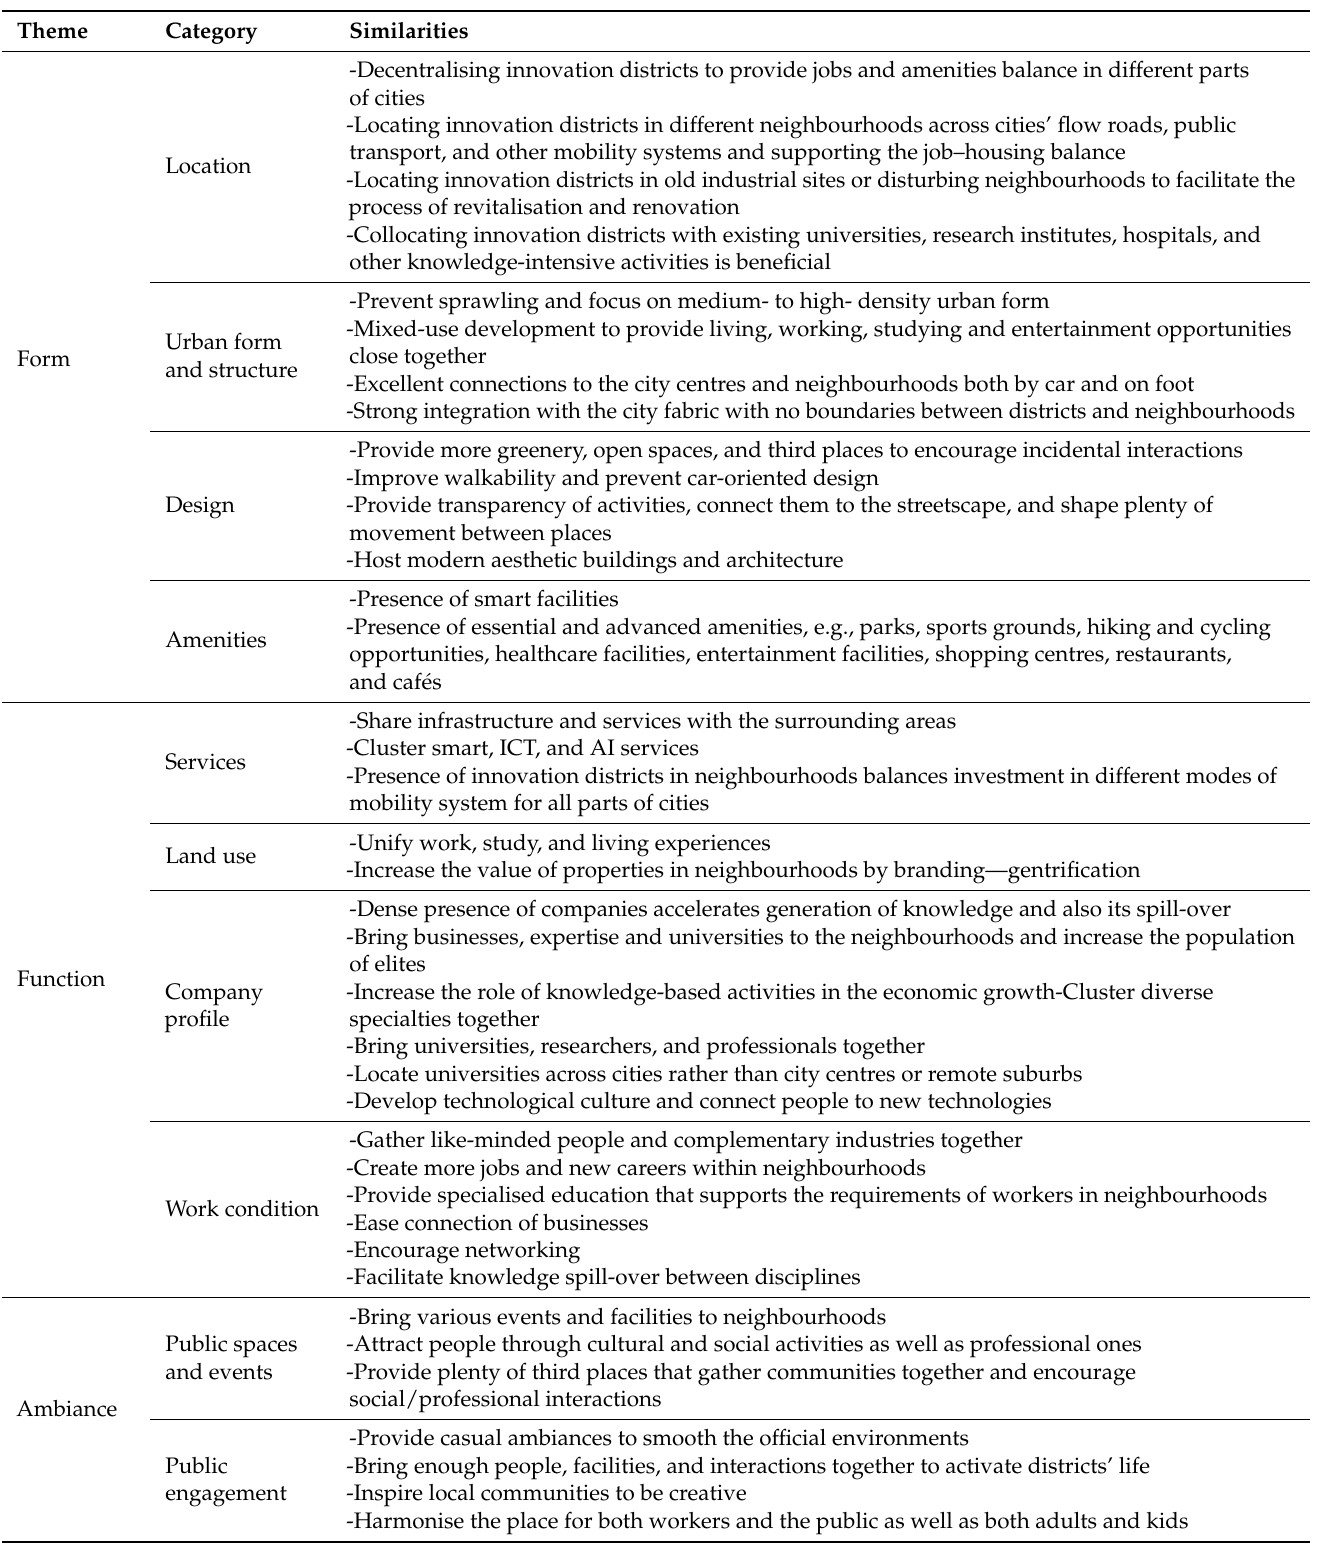
Table 3. Similar characteristics of innovation